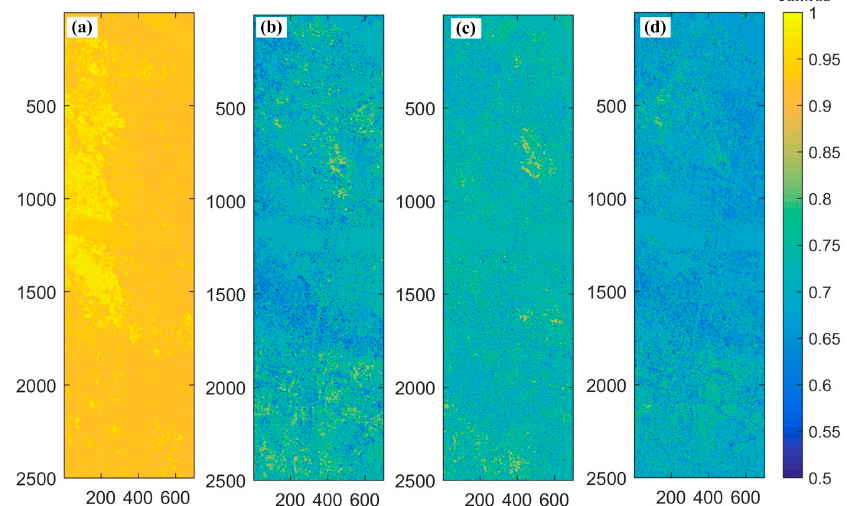
Figure 12. Mean Temporal Coherence for different models: ( a ) MVM; ( b ) PVM; ( c ) SM; ( d ) CPM.